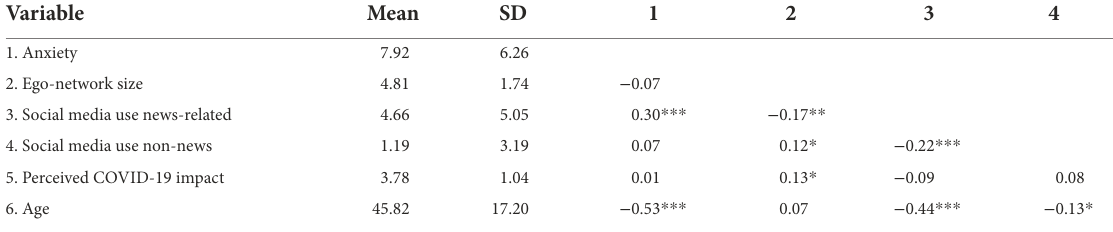
TABLE 2 Study 2 descriptives and correlation ( N = 258).